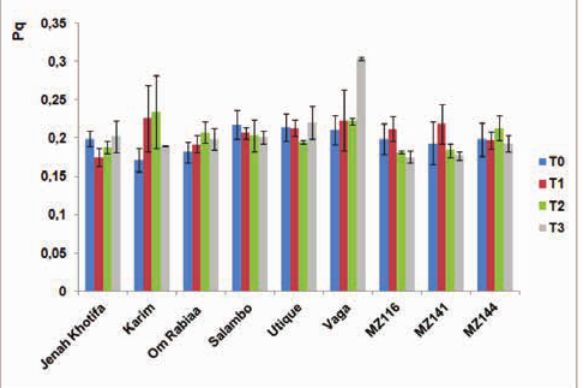
Figure 4: Variation of the photochemical quenching coefficients (Pq) among the investigated durum wheat (Jenah Khotifa, Karim, Om Rabiaa) and common wheat varieties (Salambo, Utique, Vaga) and wild wheat accessions (MZ116, MZ141, MZ144) according to the four salt treatments (T0=0, T1= 50, T2=100 and T3=150 mM